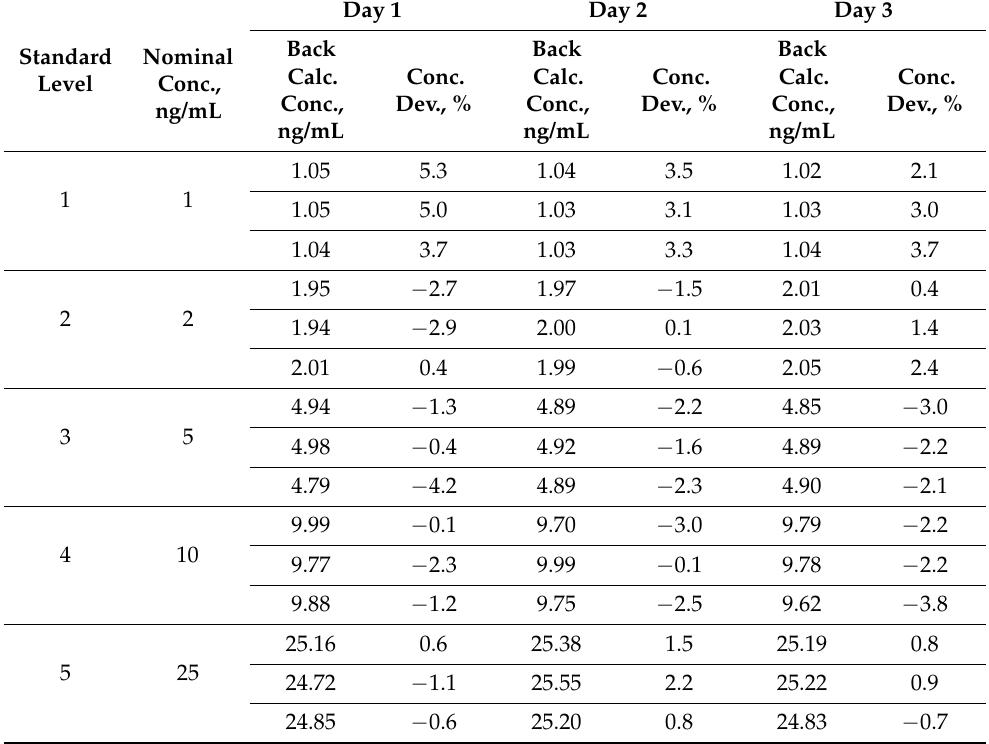
Table A5. Calibration curve data for